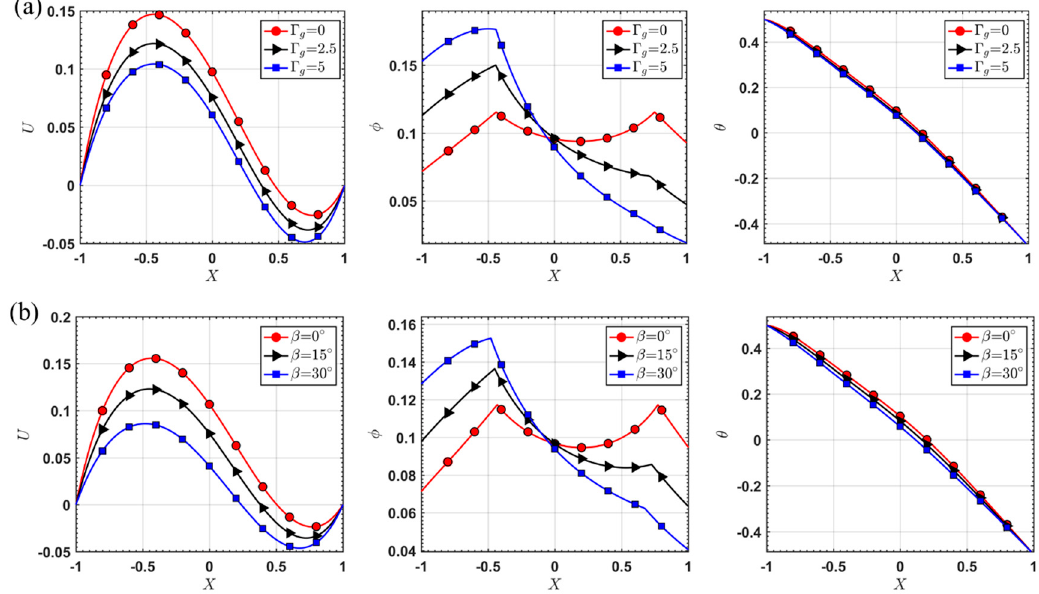
Figure 7. E ff ect of particle flux due to gravity. ( a ) E ff ect of Γ g on the velocity, concentration and temperature profiles, when 𝛤 𝑐 = 1.0 , 𝛤 𝜇 = 0.1 , 𝛽 = 10° , 𝐿𝑒 = 10 , 𝑛 = −0.5 , 𝛿 = 1 , 𝑅𝑎 = 3 , 𝐵𝑟 = 5 and φ avg = 0.1. ( b ) E ff ect of β on the velocity, concentration and temperature profiles, when Γ c = 1.0, Γ µ = 0.1, Γ g = 1, Le = 10, n = −0.5 , 𝛿 = 1 , 𝑅𝑎 = 3 , 𝐵𝑟 = 5 and 𝜙 𝑎𝑣𝑔 = 0.1 .